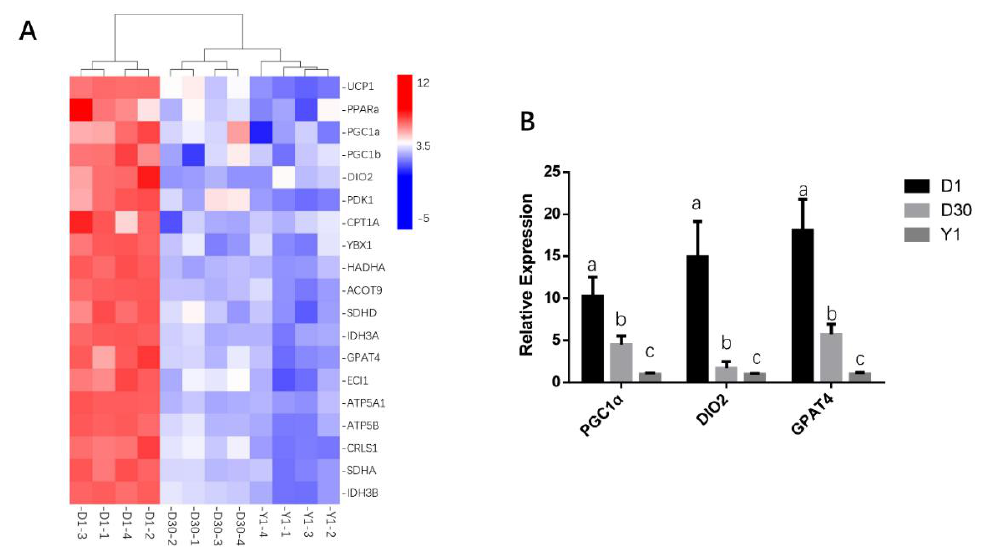
Figure 1. Characteristics of goat perirenal fat in 1 day (D1), 30 day (D30), and 1 year (Y1) ( A ) Heatmap clustering showed the BAT-related gene expression from RNA-seq. ( B ) qPCR verification showed the BAT-related marker gene expressions. TBP act as a negative control. Error bars represent standard error of mean (SEM), n = 4. The superscript in the histogram (a, b, c) showed the significance, different letters revealed that genes expressed conspicuously different among each other ( p <